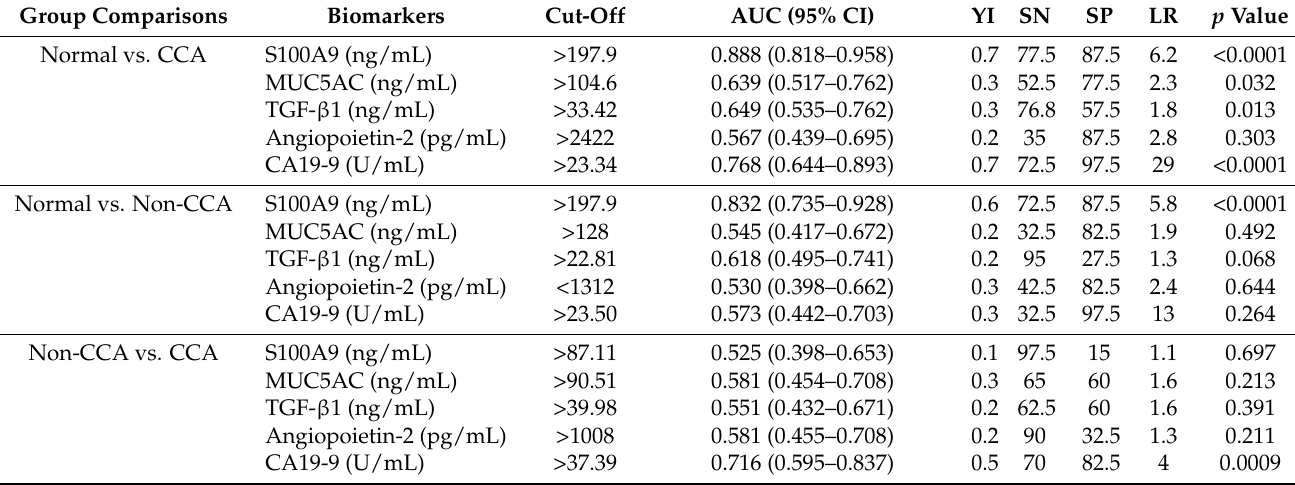
Table 3. The performance of single biomarker for CCA diagnosis, based on the best cut-off derived from ROC analysis and YI. Group Comparisons